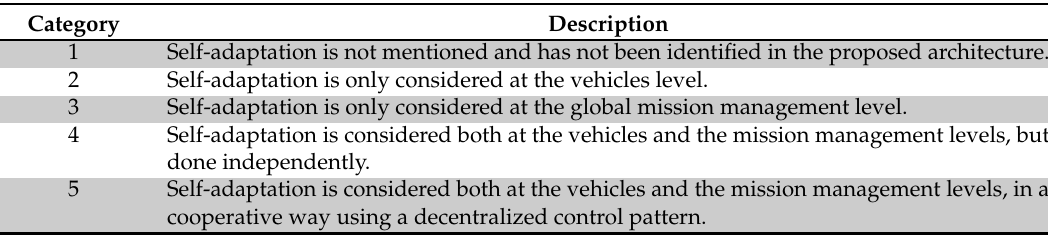
Figure 5. Diagram for the assignment of categories for the self-adaptation feature. Table 3. Self-adaptation assessment.